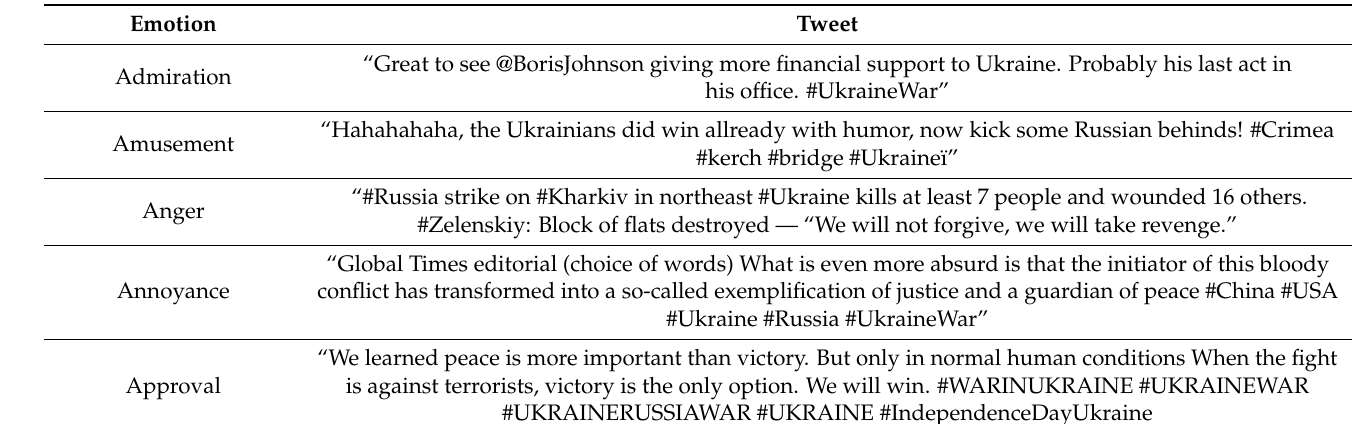
Table 2. Examples of tweets according to their extracted emotions.